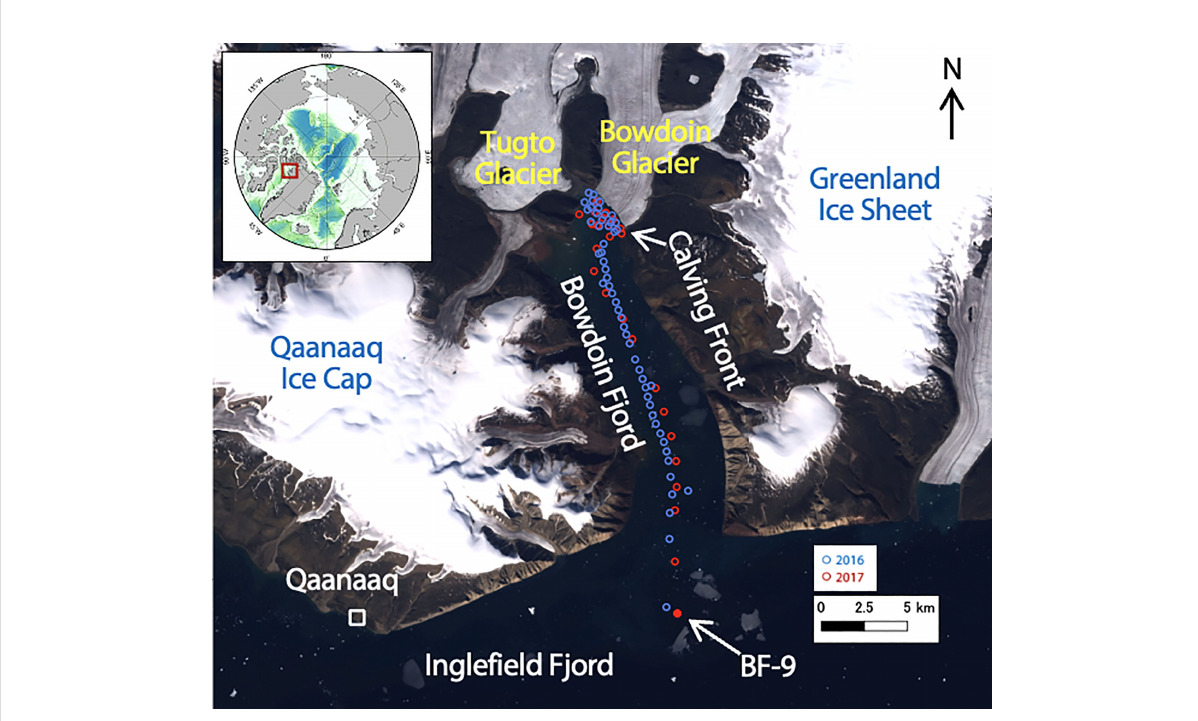
(Figure 1). Bowdoin Glacier (Kangerluarsuup Sermia in Greenlandic; Bjørk et al., 2015) is a marine-terminating outlet glacier in northwestern Greenland that discharges freshwater into Bowdoin Fjord along a 3-km-wide calving front. The ice thickness is approximately 250 – 400 m